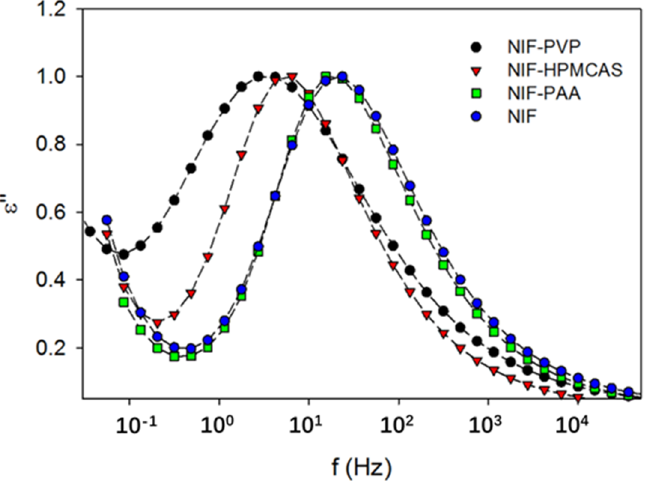
Figure 4. Dielectric loss peak of pure nifedipine and nifedipine systems with 10% PVP, HPMCAS, and PAA at 60 °C. Adapted from Ref. [49] with permission. Copyright © 2015 American Chemical PAA at 60 ◦ C. Adapted from Ref. [49] with permission. Copyright © 2015 American Chemical Society.